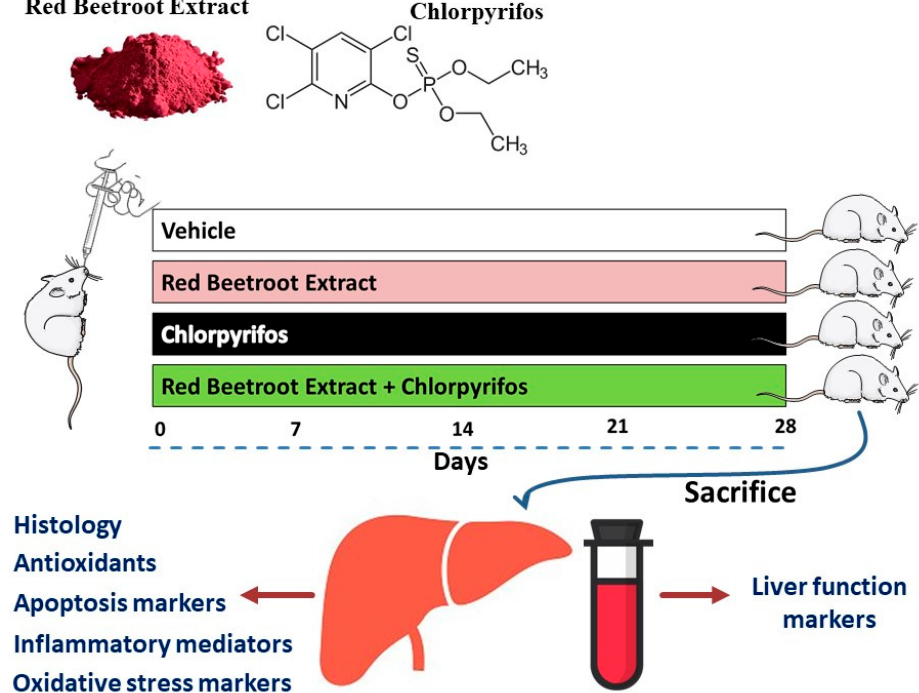
Figure 1. A schematic diagram showing the experimental design.